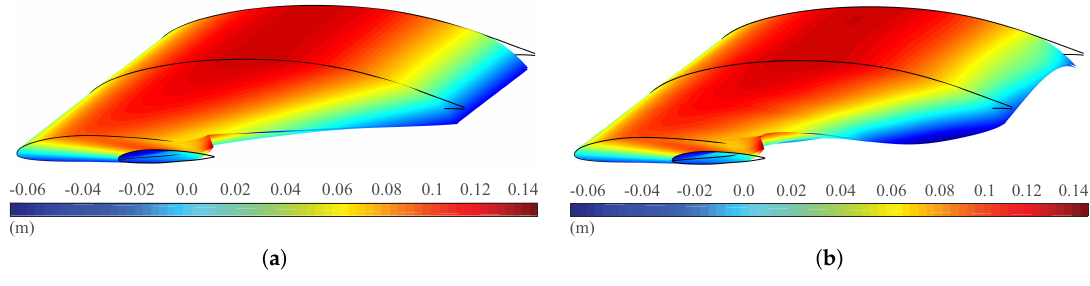
Figure 6. Parametric shapes representing the GRA wing geometry equipped with a morphing trailing edge device: colors indicate the values of the vertical position function z ( x , y ) obtained by linear ( a ) and piecewise ( b ) interpolation of four morphing trailing edge sections in span direction; the reference system is the leading edge of the root